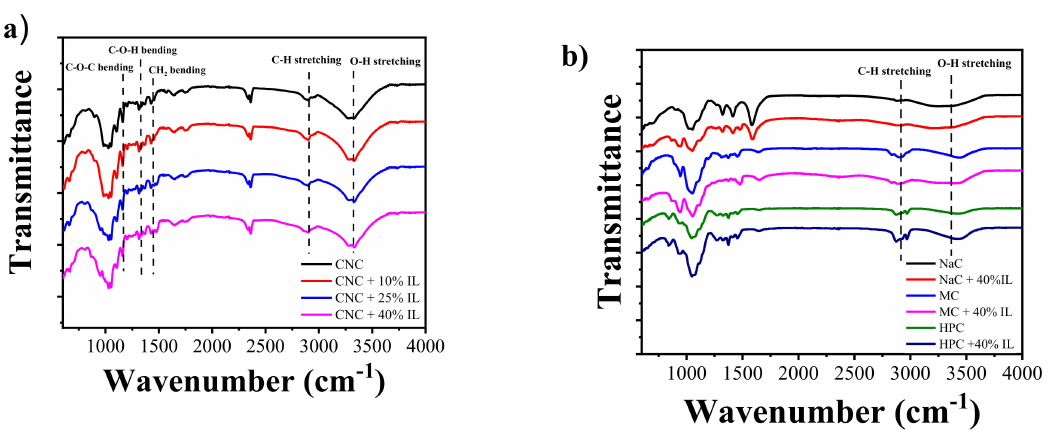
Figure 3. Fourier transform infrared spectroscopy (FTIR)-attenuated total reflection (ATR) spectra of ( a ) pure CNC and CNC / [Ch][DHP] composite films and ( b ) pure cellulose derivative and cellulose derivative / [Ch][DHP] films containing 40% wt. of